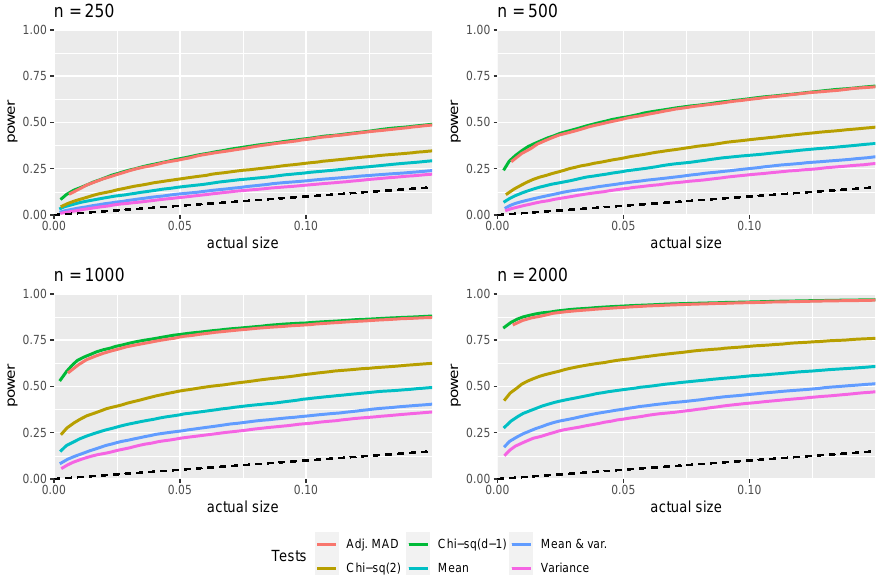
Figure 5. First digit tests: size–power curves of the tests against the perturbed mixing alternative with λ = 0.75. Tests are as follows: “Adj. MAD”, adjusted MAD (10); “Chi-sq(2)”, χ 2 ( 2 ) test on mean and variance (4); “Chi-sq(d-1)”, χ 2 ( 8 ) test (9); “Mean”, normal test on the mean (1); “Mean & var.”, normal test on mean and variance (3); “Variance”, normal test on variance (2). The dashed line is power = actual size . The number of observations is indicated on top of each